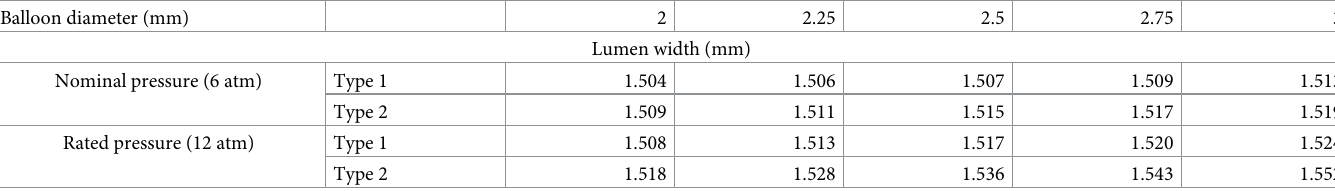
Table 3. Lumen width at the inner surface of the calcification model at the longitudinal and circumferential ends. Balloon diameter